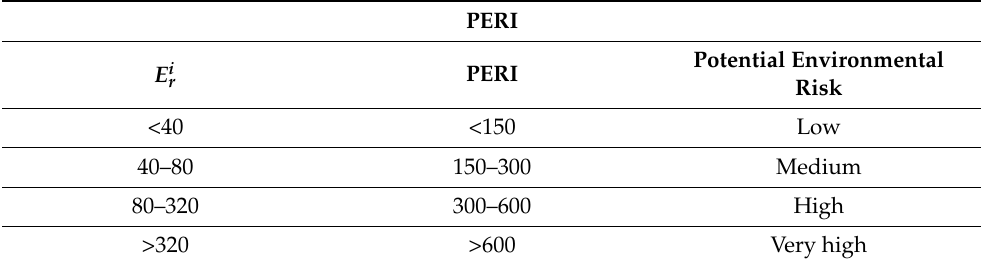
Table 5. Potential environmental risk index (PERI) indicator classification